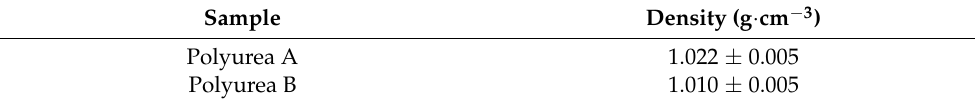
Table 1. Density test results.